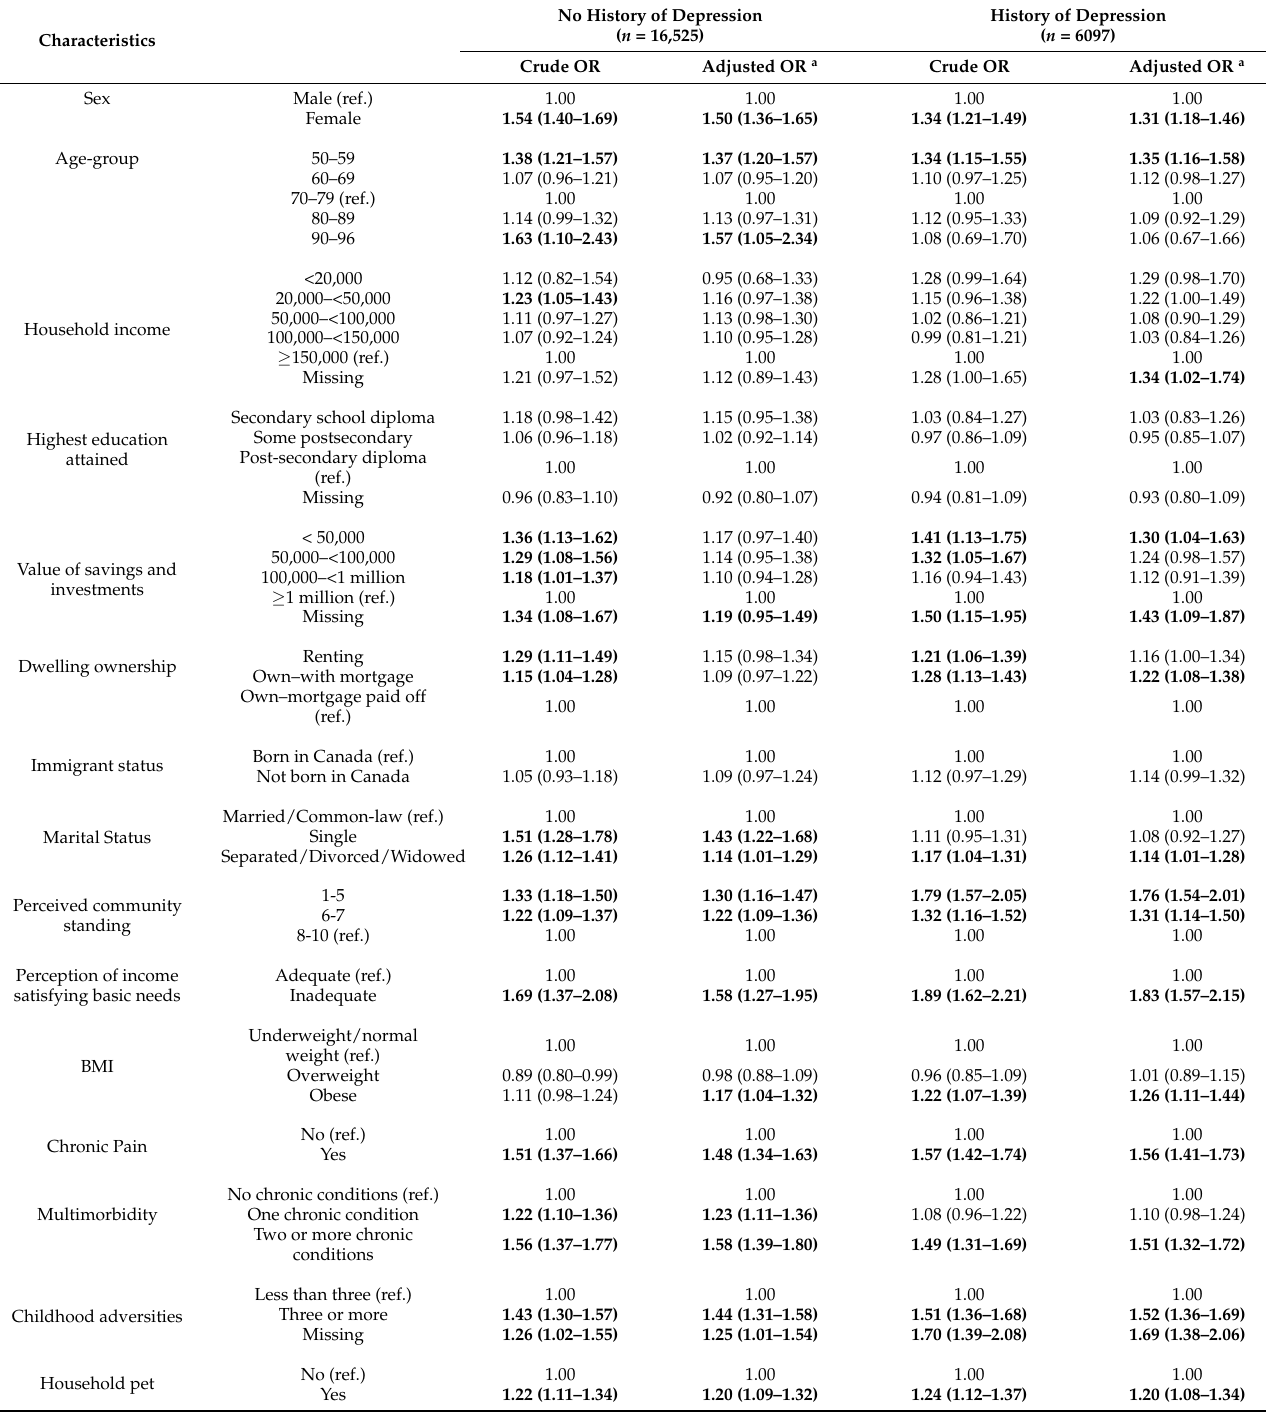
Table 3. Predictors of depression at the Autumn 2020 questionnaire among those with no history of depression and those with any history of